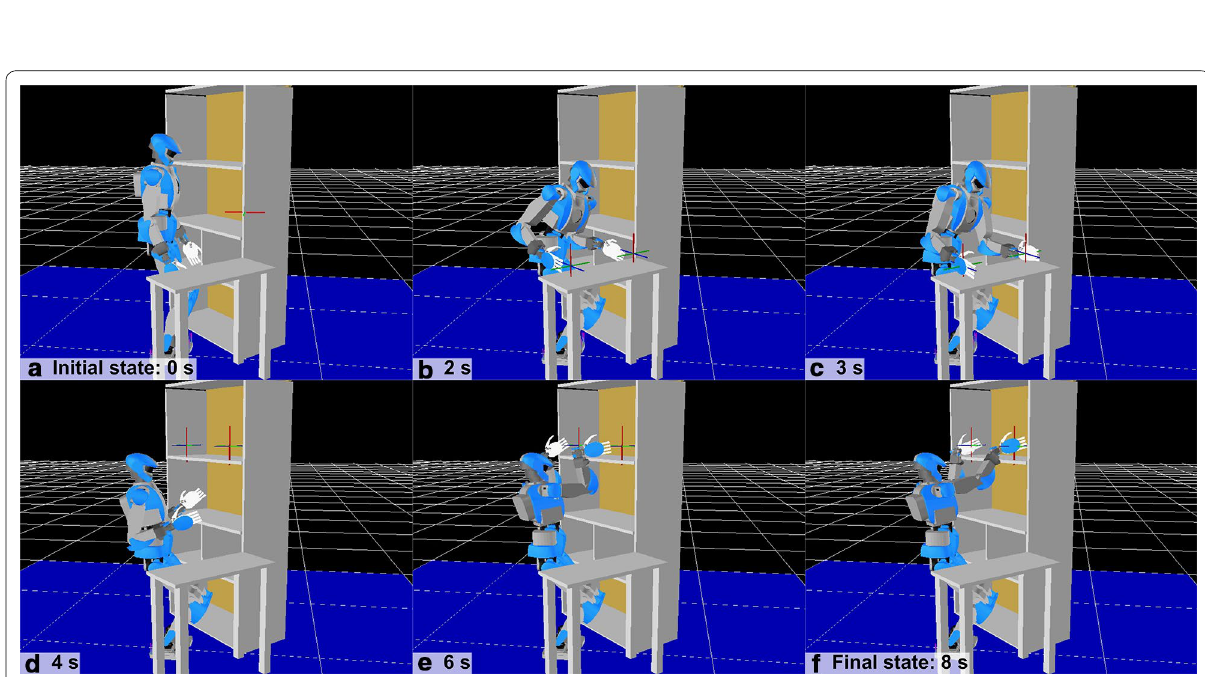
Fig. 16 Simulation results when approaching target positions with both hands in a living environment. There is a table and a shelf in the dynamics simulation environment. To avoid collisions, we set waypoints when approaching the target positions of each object (parts ( b ) and ( e ) in this figure). First, the HRP-4 approaches the target objects on the table. Then, the HRP-4 moves to the target objects on the shelf ( a initial state, c and d